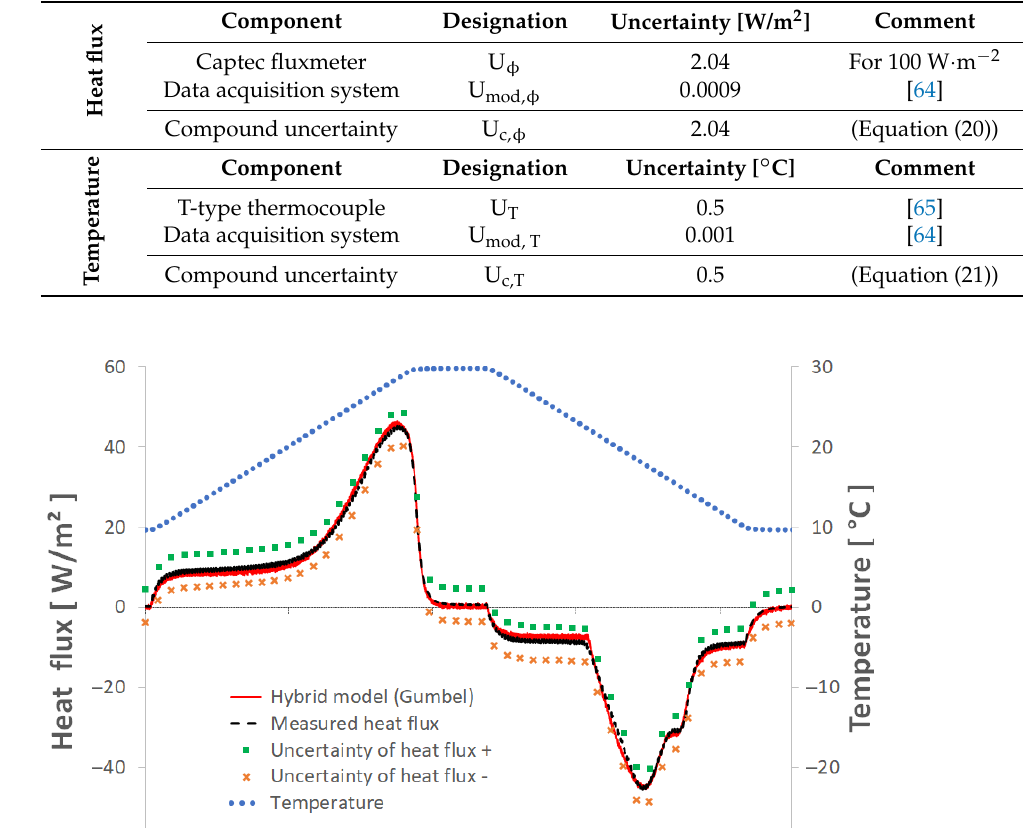
Table 8. Uncertainties related to the heat flux and temperature measurements.